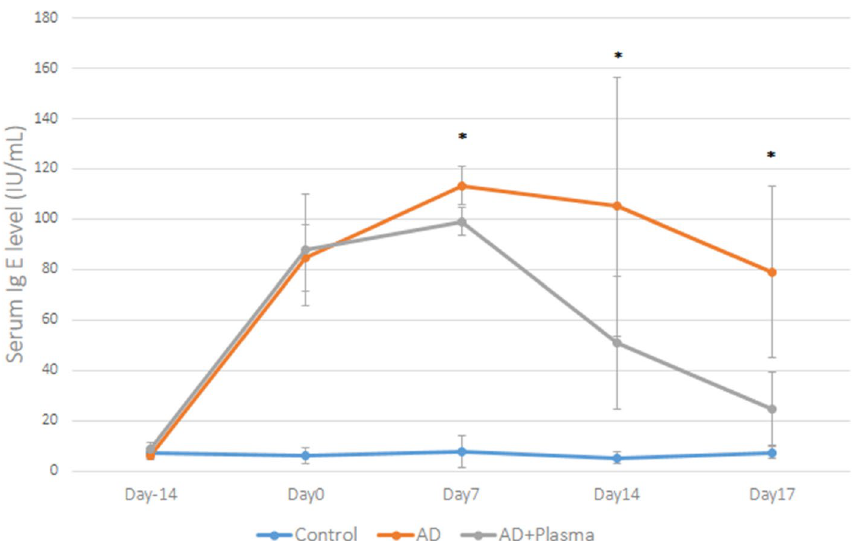
Figure 5. Changes in serum Ig E levels with or without plasma treatment. After induction of atopic dermatitis- like skin lesions in mice, serum Ig E levels were notably elevated (Day 0). Compared to the non-treated AD group, the AD + plasma showed significantly lower levels of serum Ig E starting on Day 7, lasting to the end of the experiment on Day 17. *P <